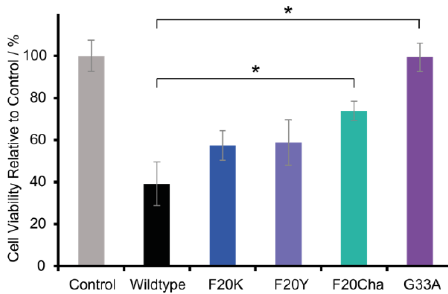
Figure 6. Relative cell viability of RN46A cells incubated with peptide variants or the vehicle for the control group, respectively. The concentration of Aβ (1–40) WT or the mutant species was 100 µM, cells were incubated for 60 h at 37 °C. The cell viability of the control group was set to 100%. Error bars represent standard errors of the mean, * represents p < 0.005.